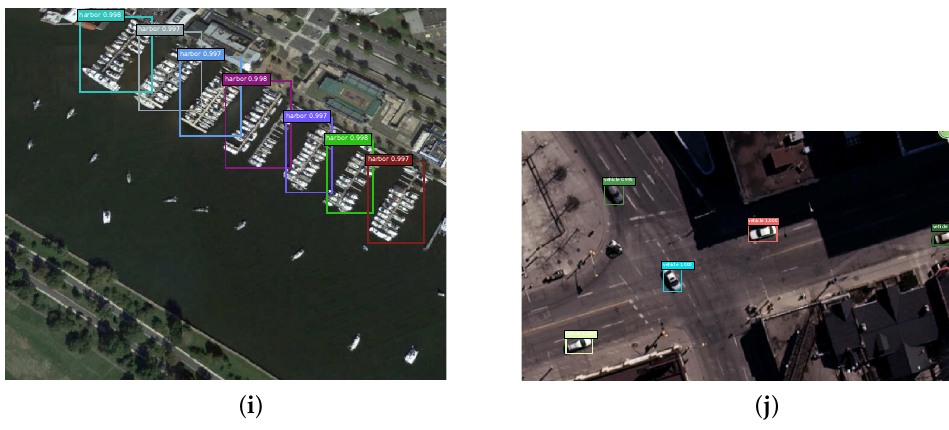
Figure 6. Visualization of some objects detection results by deformable R-FCN in the NWPU VHR-10 dataset. Detected objects such as ( a ) airplanes; ( b ) ships; ( c ) bridges; ( d ) storage tanks; ( e ) baseball diamonds; ( f ) tennis courts; ( g ) basketball courts; ( h ) ground track fields; ( i ) harbors; ( j ) vehicles are